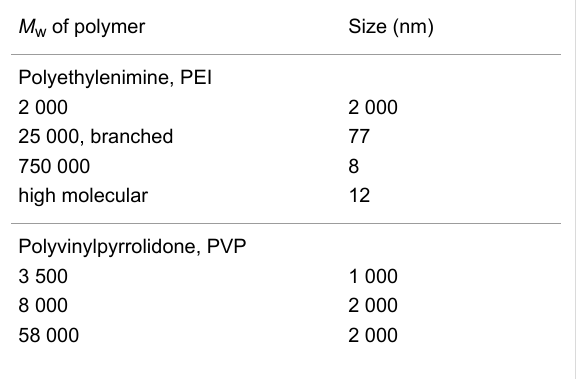
Table 2: SnO 2 particle size dependence on the type of polymer and its average molecular weight. The amount of Triton X-100 was held